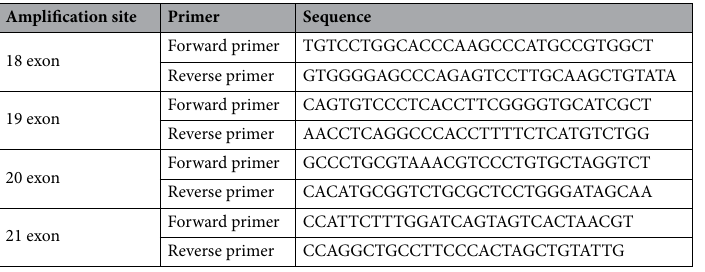
Table 9. The primer sequences of EGFR 18–21